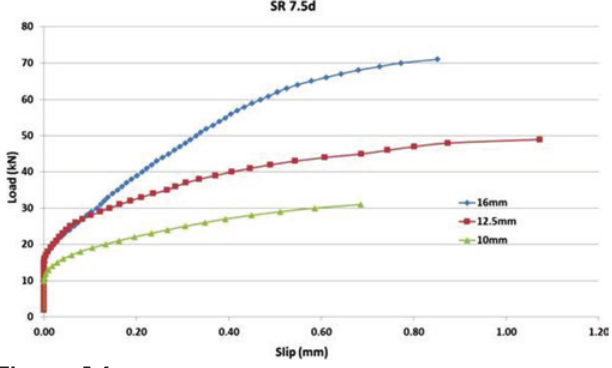
Figure 15 Influence of the bar diameter, models: 10-5-1; 12.5-5-1;